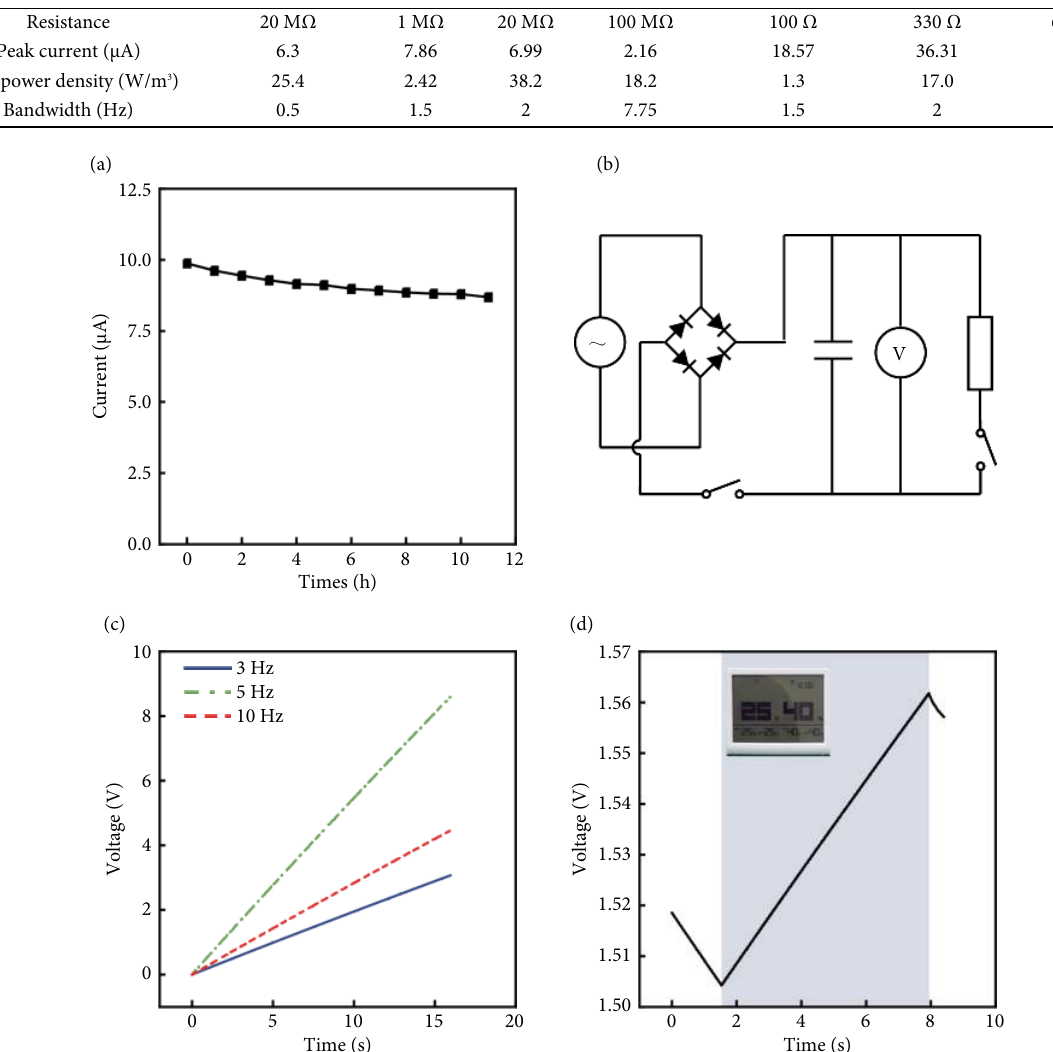
Fig. 4 Application of NN-TENG. (a) Current decay with time, (b) the equivalent circuit diagram of the self-powered system for powering various electronic devices, (c) charging curves of the capacitor by the TENG, and (d) the hygrometer powered by the